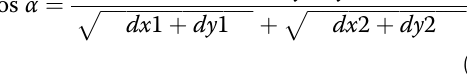
vector on x - and y -axes is denoted by d x and d y , respectively.